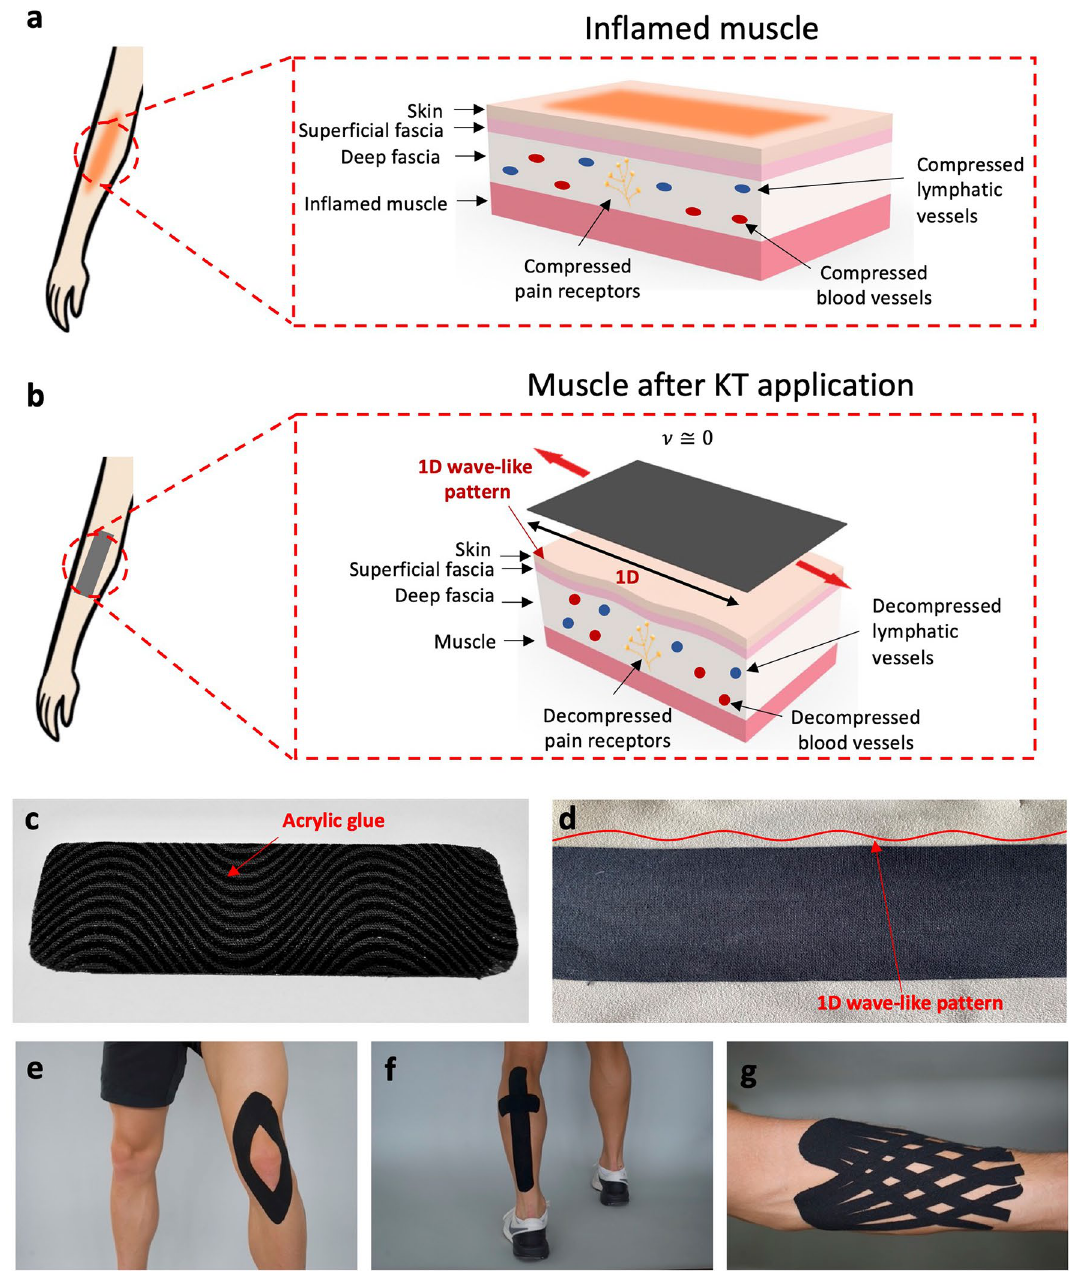
Figure 1. Existing KT ( a ) The compression on the skin, fascia, and muscle due to an injury. Image inspired by 22–24 . ( b ) The positive decompressive effect generated by the KT application. A one-dimensional wave-like pattern is generated on the skin. Image inspired by 22–24 . ( c ) The wave-like pattern of the acrylic adhesive at the bottom of a KT. ( d ) The one-dimensional wave-like pattern visible to the bare eye when a KT is applied to a leather sample used to mimic the skin. ( e, f, g ) Examples of KT applications on the knee ( e ) and on the calf ( f ). In ( g ) the application of a fan-shaped tape on the forearm for lymphatic